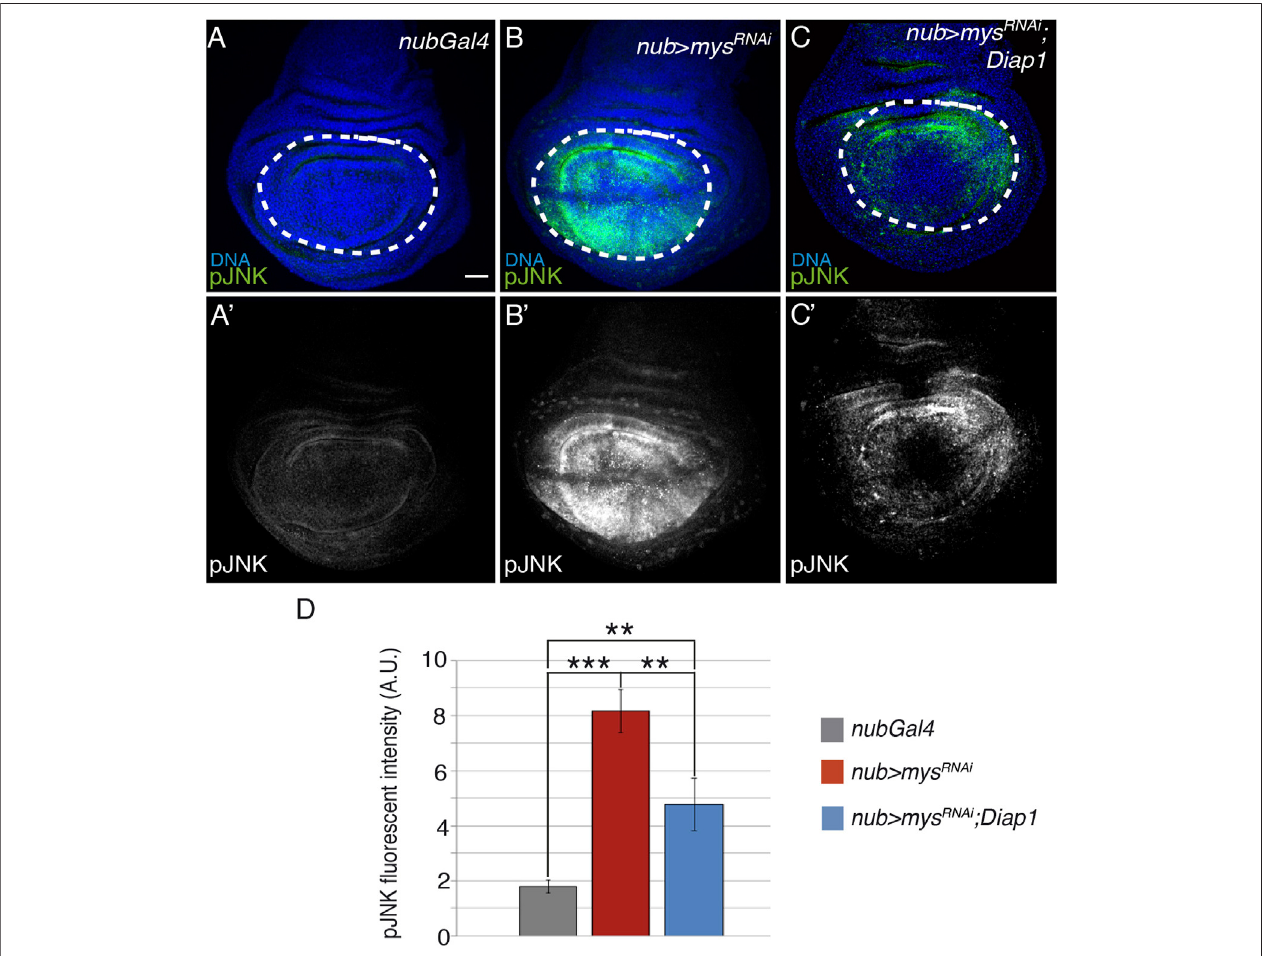
FIGURE 3 | Elimination of integrins activates the JNK pathway. (A – C 9 ) Maximal projection of confocal views of wing imaginal discs from third-instar larvae stained withanti-pJNK [green in (A – C) , whitein (A 9 – C 9 )] and thenuclear marker Hoechst [DNA, blue in (A – C) ]. (A,A 9 ) Control nubGal4 wing disc. (B,B 9 ) Wing disc expressing a mys RNAi under the control of nubGal4 , nub > mys RNAi . (C,C 9 ) Wing disc co-expressing RNAi against mys and Diap1 under the control of nubGal4 , nub > mys RNAi ; Diap1 . (D) Quanti fi cation of pJNK levels in wing discs of the indicated genotypes. The statistical signi fi cance of differences was assessed with a t -test, *** and ** p values < 0.001 and < 0.01, respectively. Scale bar in all panels, 30 μ m.